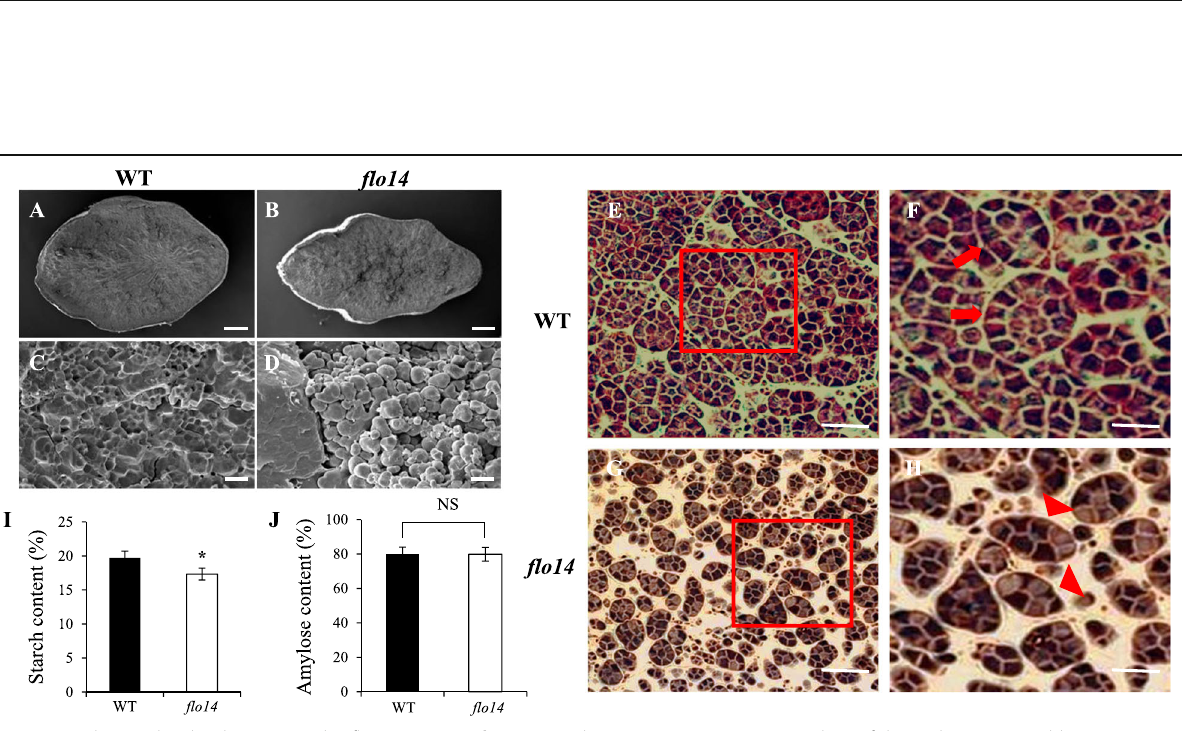
Fig. 2 Starch granules development in the flo14 mutant. a - d Scanning electron microscope (SEM) analysis of the endosperm in wild-type (WT) ( a , c ) and flo14 mutant ( flo14 ) ( b , d ) seeds. e-h Semi-thin sections of wild-type and flo14 mutant seeds. The central part of 12 days after flowering (DAF) in the wild-type endosperm cells ( e-f ) and the central part of mutant flo14 endosperm cells ( g-h ). i Starch content of wild type and flo14 mutant ( n =3 each). j Amylose content of wild type and flo14 mutant ( n =3 each). Data are shown as means ± SD (from at least three independent samples) and was compared with wild type by Student ’ s t -test (* P <0.05). NS: no obviously changed. Scale bars: 0.5mm in ( a , b ), 15 μ m in ( c , d ), 100 μ m in ( e , g ), 200 μ m in ( f , h